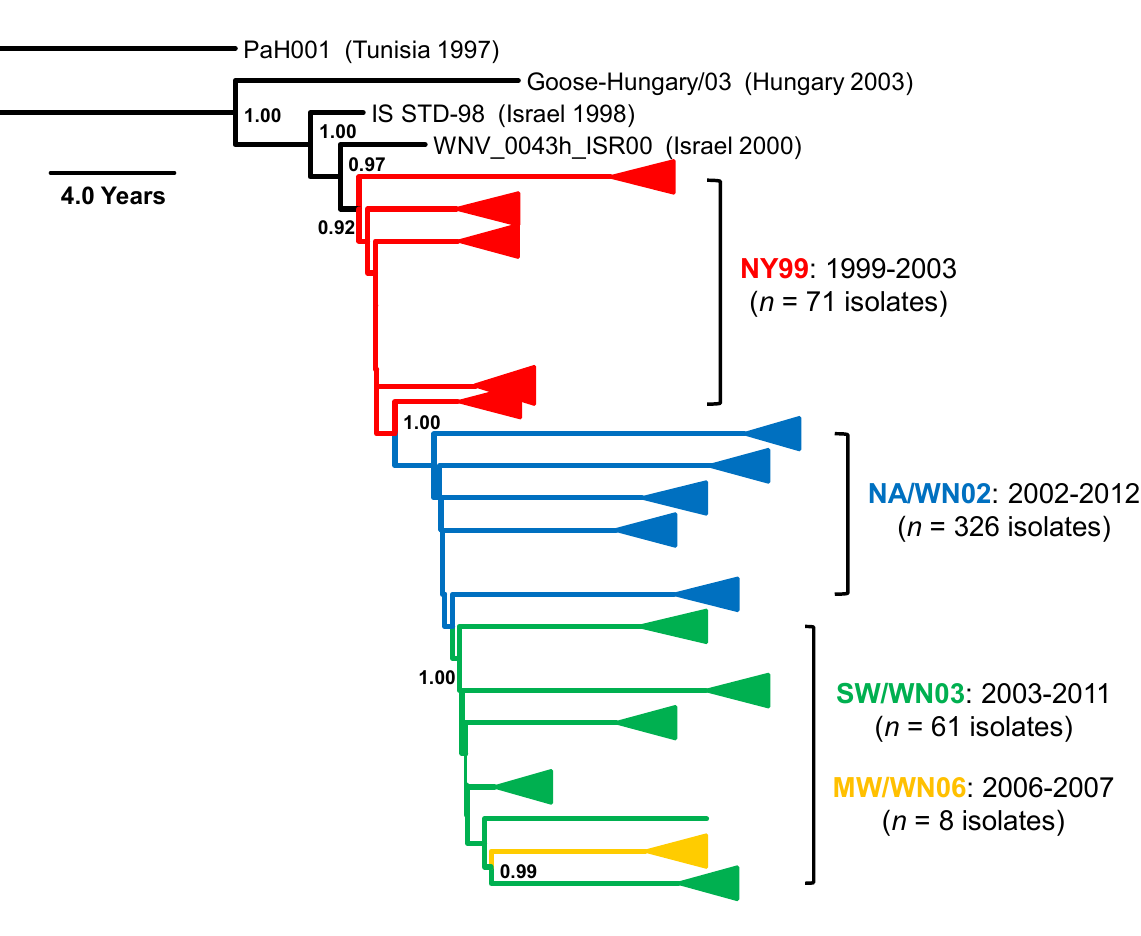
Figure 2. Bayesian coalescent phylogenetic tree depicting the simplified distribution of the North American WNV genotypes within Lineage 1a Cluster 4. Posterior probabilities ( ≥ 0.92) support the emergence of at least four unique WNV genotypes and/or clusters in North America from ancestral North African strains: NY99 (red), NA/WN02 (blue), SW/WN03 (green), and MW/WN06 (gold). Both the number and temporal range are indicated for the isolates which cluster within each genotype or cluster. Scale bar, divergence time in